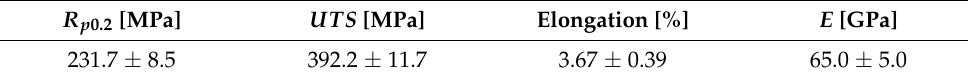
Table 3. The tensile properties of vertically built AlSi10Mg samples.